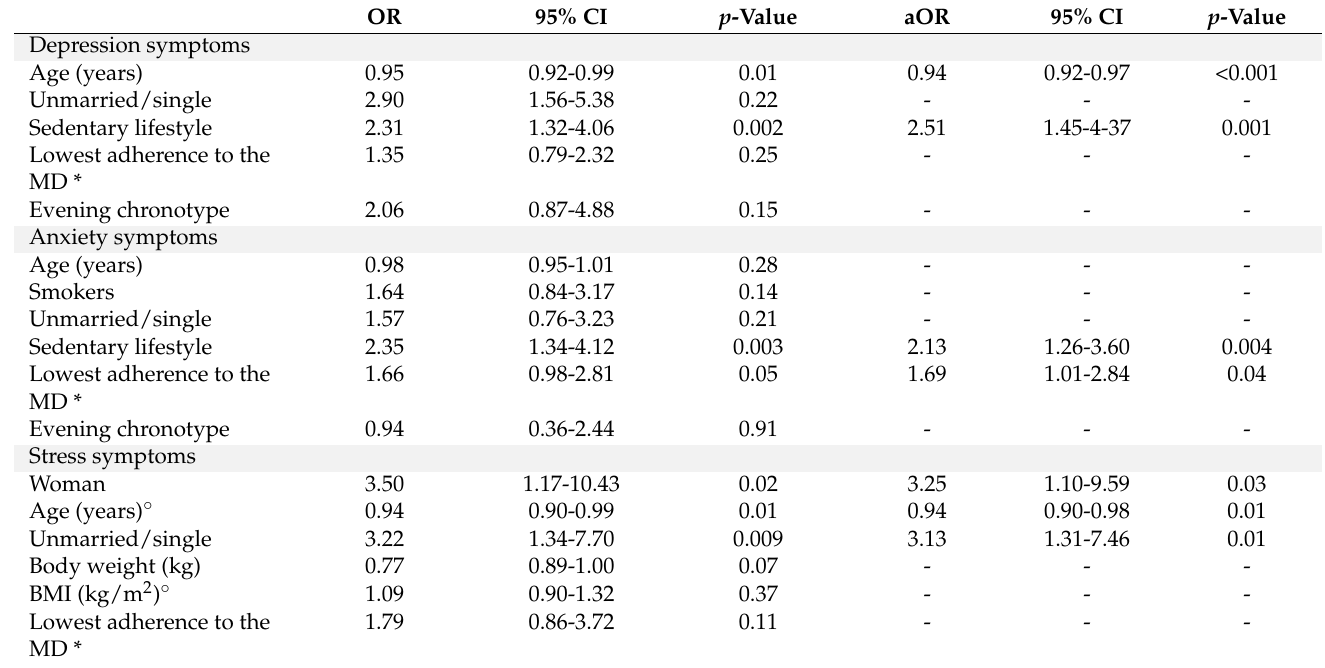
Table 2. Univariate and multivariate analyses of independent variables associated with psychological